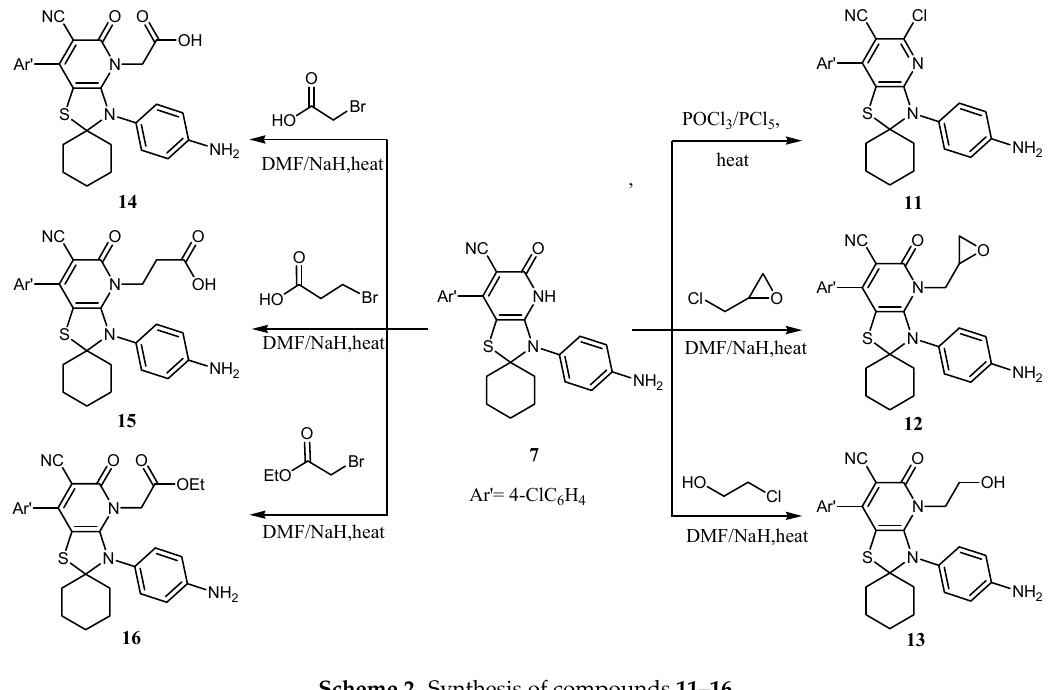
Table 1. Effect of treatment at various concentrations of prepared compounds on MCF-7 and HepG-2 cell